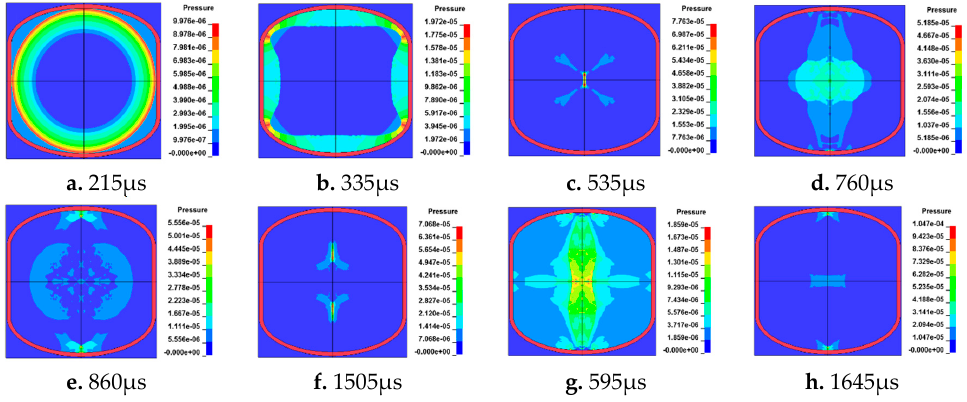
Figure 8. Internal explosion nephogram under the 1.00 vessel aspect ratio.